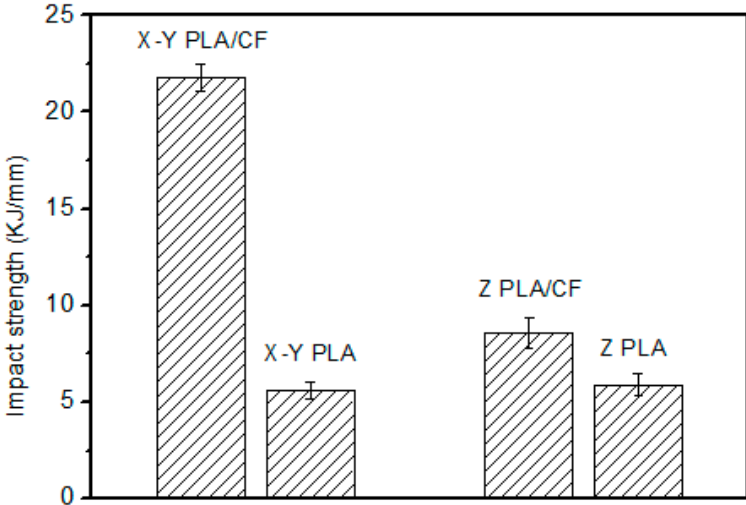
Figure 5. Strength of the polylactic acid–carbon fiber (PLA–CF) specimens. 155